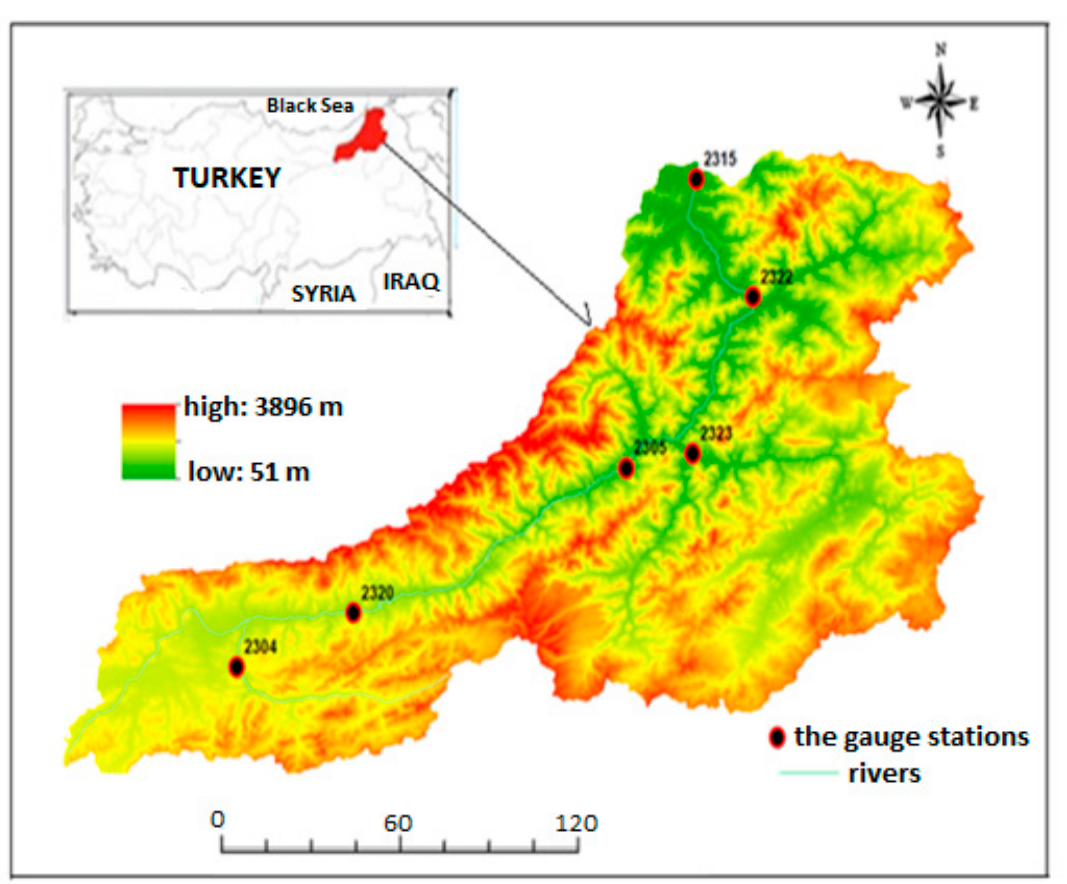
Figure 1. Study area and spatial distribution of the gauge stations used in the present study.